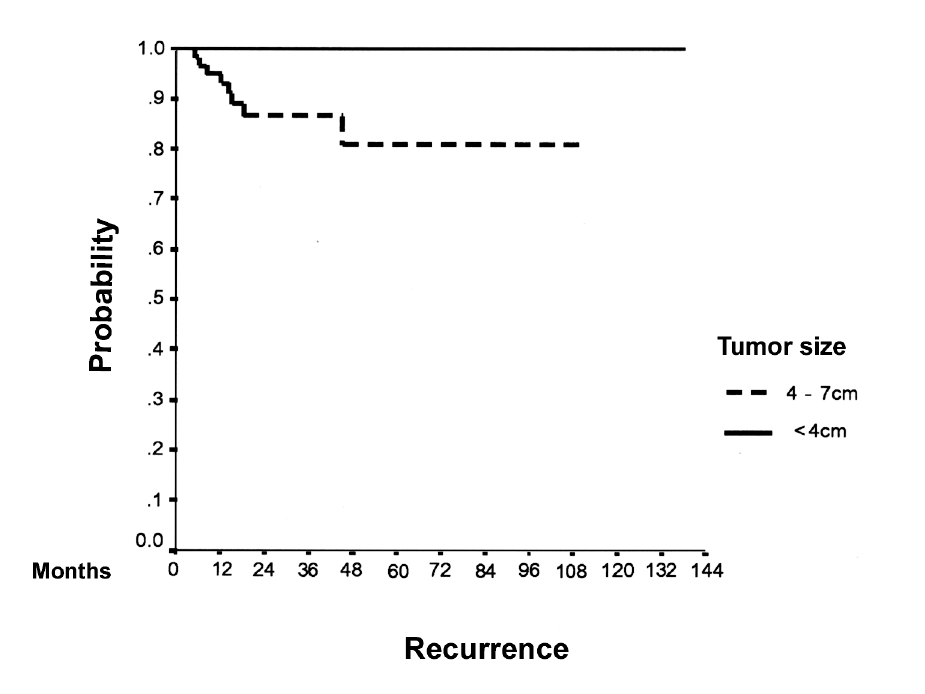
Figure 1 - Disease-free survival curves (p =